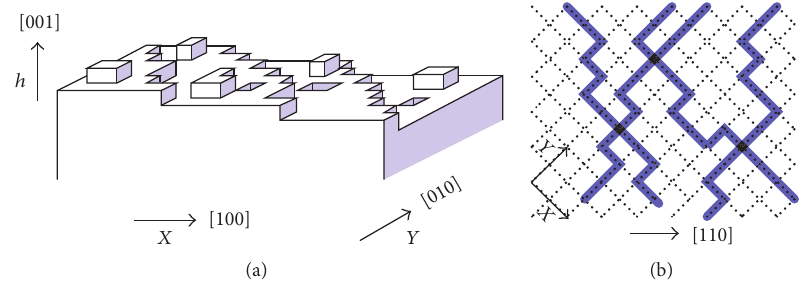
Figure 2: (a) Perspective view of the RSOS model tilted towards the direction ⟨110⟩ . (b) Top-down view of the RSOS model. The thick blue lines show the surface